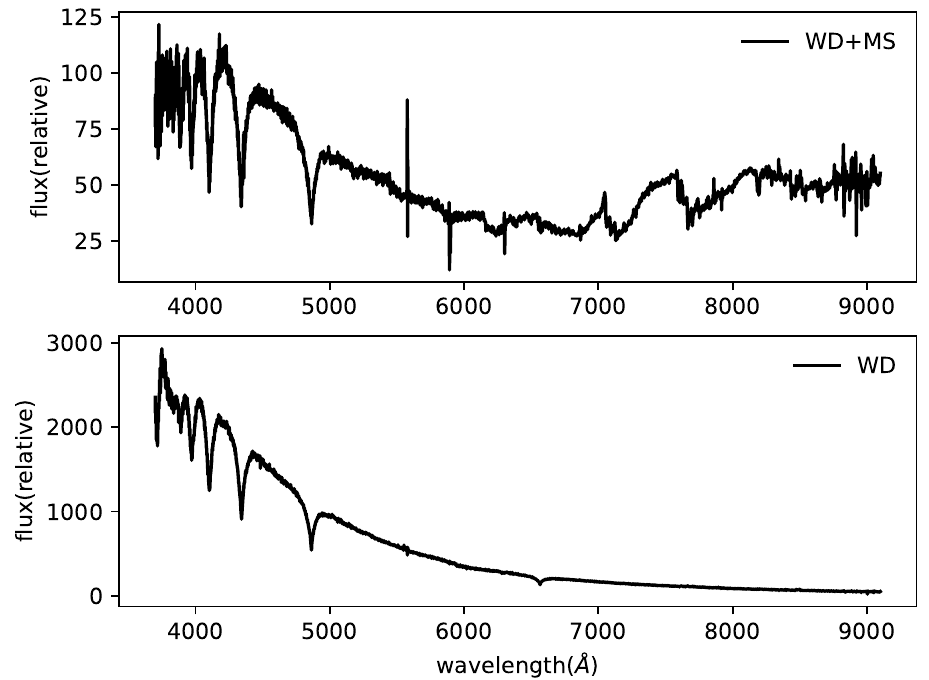
Figure 12. Spectra of DA + MS binary and single WD. The upper panel shows the spectrum of WD + MS, while the lower panel shows the spectra of